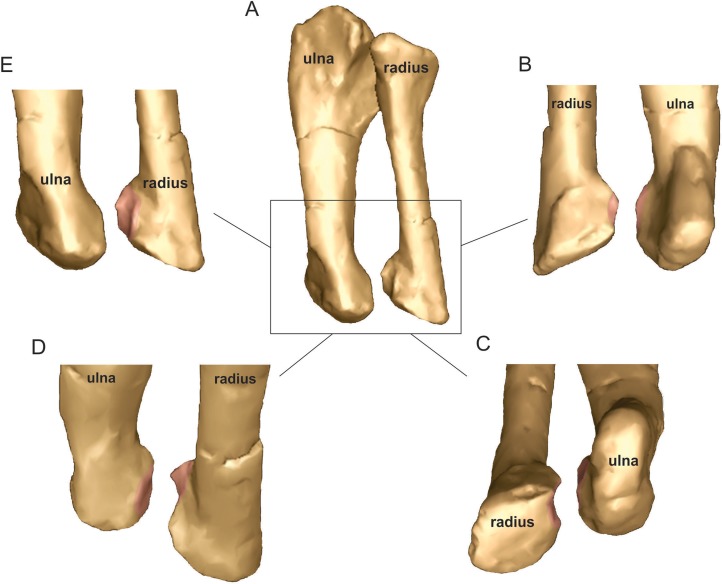
Antebrachial bones of Mussaurus patagonicus.Radius and ulna (A) showing the articulation of the distal ends in medial (B), distomedial (C), dorsolateral (D) and lateral (E) views. Not to scale.